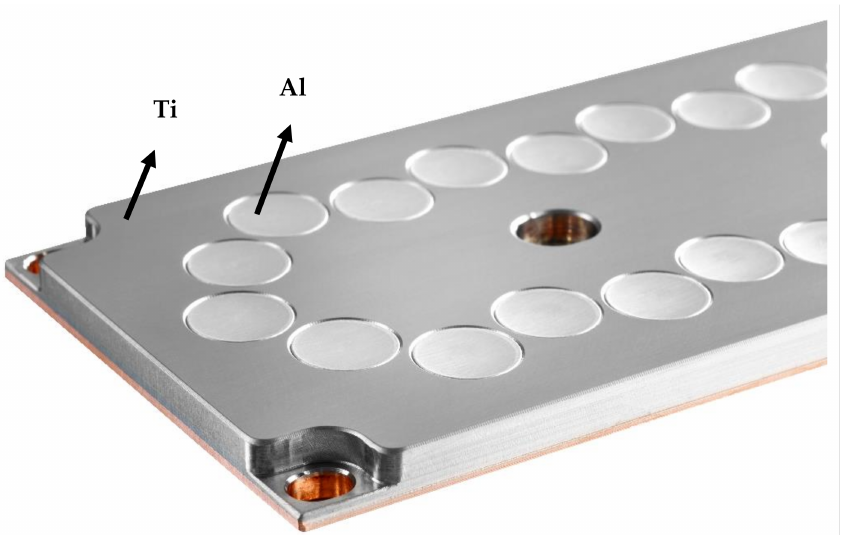
Figure 3. TiAl target with a nitrogen atmosphere for preparation of TiAlN coating (source Ceme- Con)